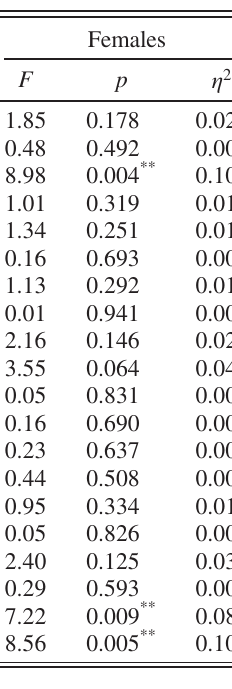
TABLE III. MANCOVA analyses: Univariate effects of gender compatibility and math-gender stereotypes on math and physics self- concepts (age and math and physics GPA scores are covariates) ( n ¼ 170